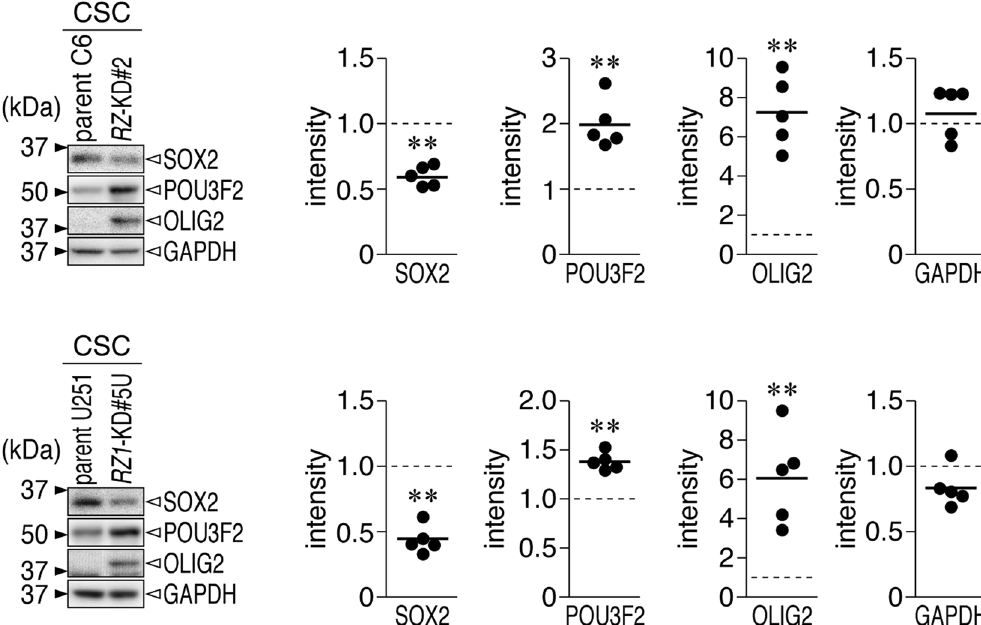
Figure 2. Altered expression of core transcription factors in Ptprz -knockdown glioblastoma cells. Western blots using antibodies against SOX2, OLIG2, POU3F2, and SALL2. Parental C6 and RZ -KD#2, and parental U251 and RZ1 -KD#5U cells were cultured in CSC medium as in Fig. 1A. SALL2 proteins were not detected in C6 or U251 cells. Sample loading was verified by immunostaining with GAPDH. Images are representative of five independent cultures. The plots show the relative densitometric units of the staining intensity in the PTPRZ -knockdown cells and the staining intensity in the parental cells. * P < 0.05; ** P < 0.01 (Student’s t -test). Full-length blots and gels are presented in Supplementary Fig.